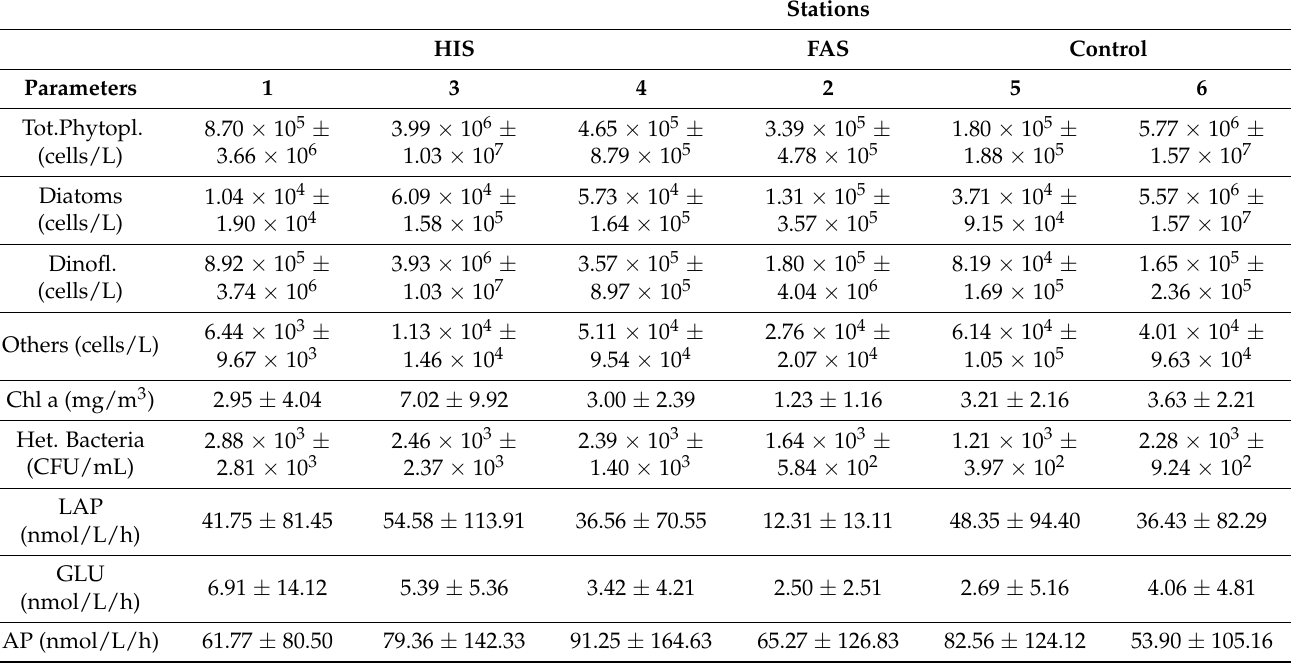
Table 4. Mean values ± standard deviation of the microbiological parameters measured in the Syracuse bay, separately per human-impacted stations (HIS), Stations 1, 3 and 4; freshwater-affected (FAS), Station 2; control stations (control), Stations